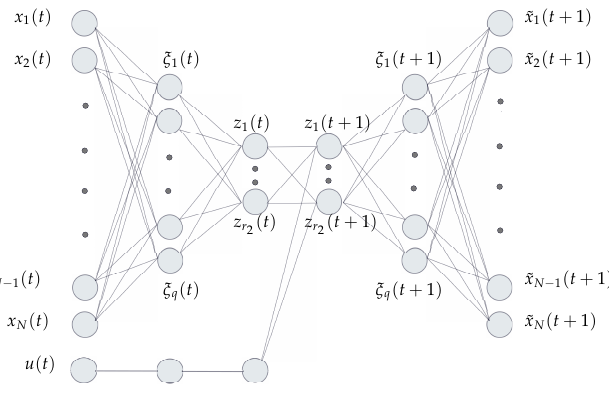
Figure 4. Network-based model-order reduction scheme consisting of an autoencoder network in combination with a linear DMDc-based network.